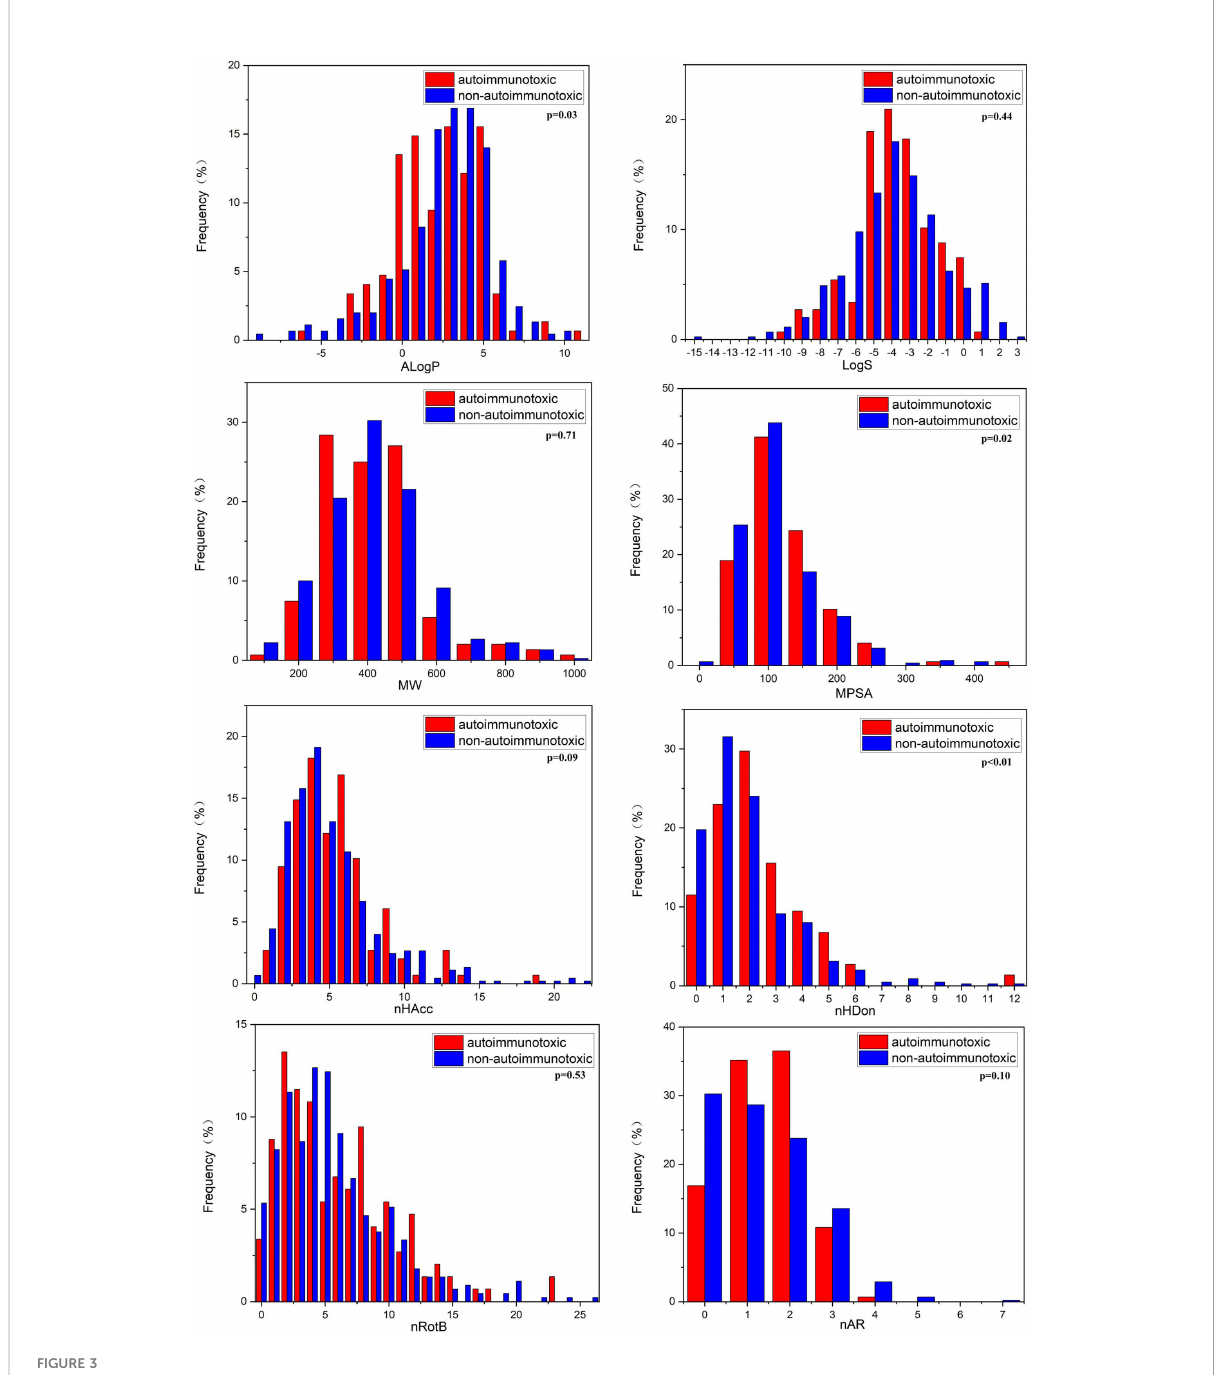
FIGURE 3 Distributions of the molecular properties for DIAD and non-DIAD